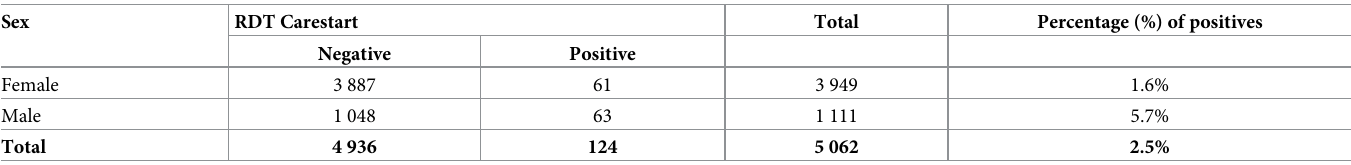
Table 2. Prevalence of G6PDd by sex in Cape